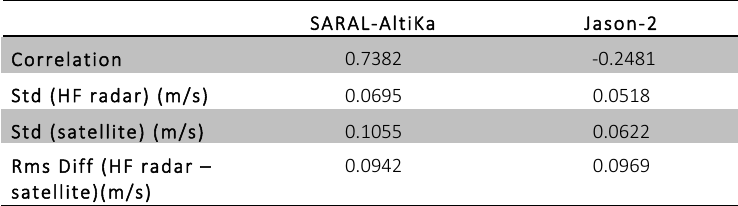
Table 1. Statistics of the comparisons between HF radar and altimetric across-track geostrophic velocities over the period comprised between 18 April 2013 and 8 May 2014. Twelve measurements are used for SARAL/AltiKa (repeat cycle of 35 days) and 36 measurements are considered for Jason-2 (repeat cycle of 9.9156 days; note that several cycles were missing for